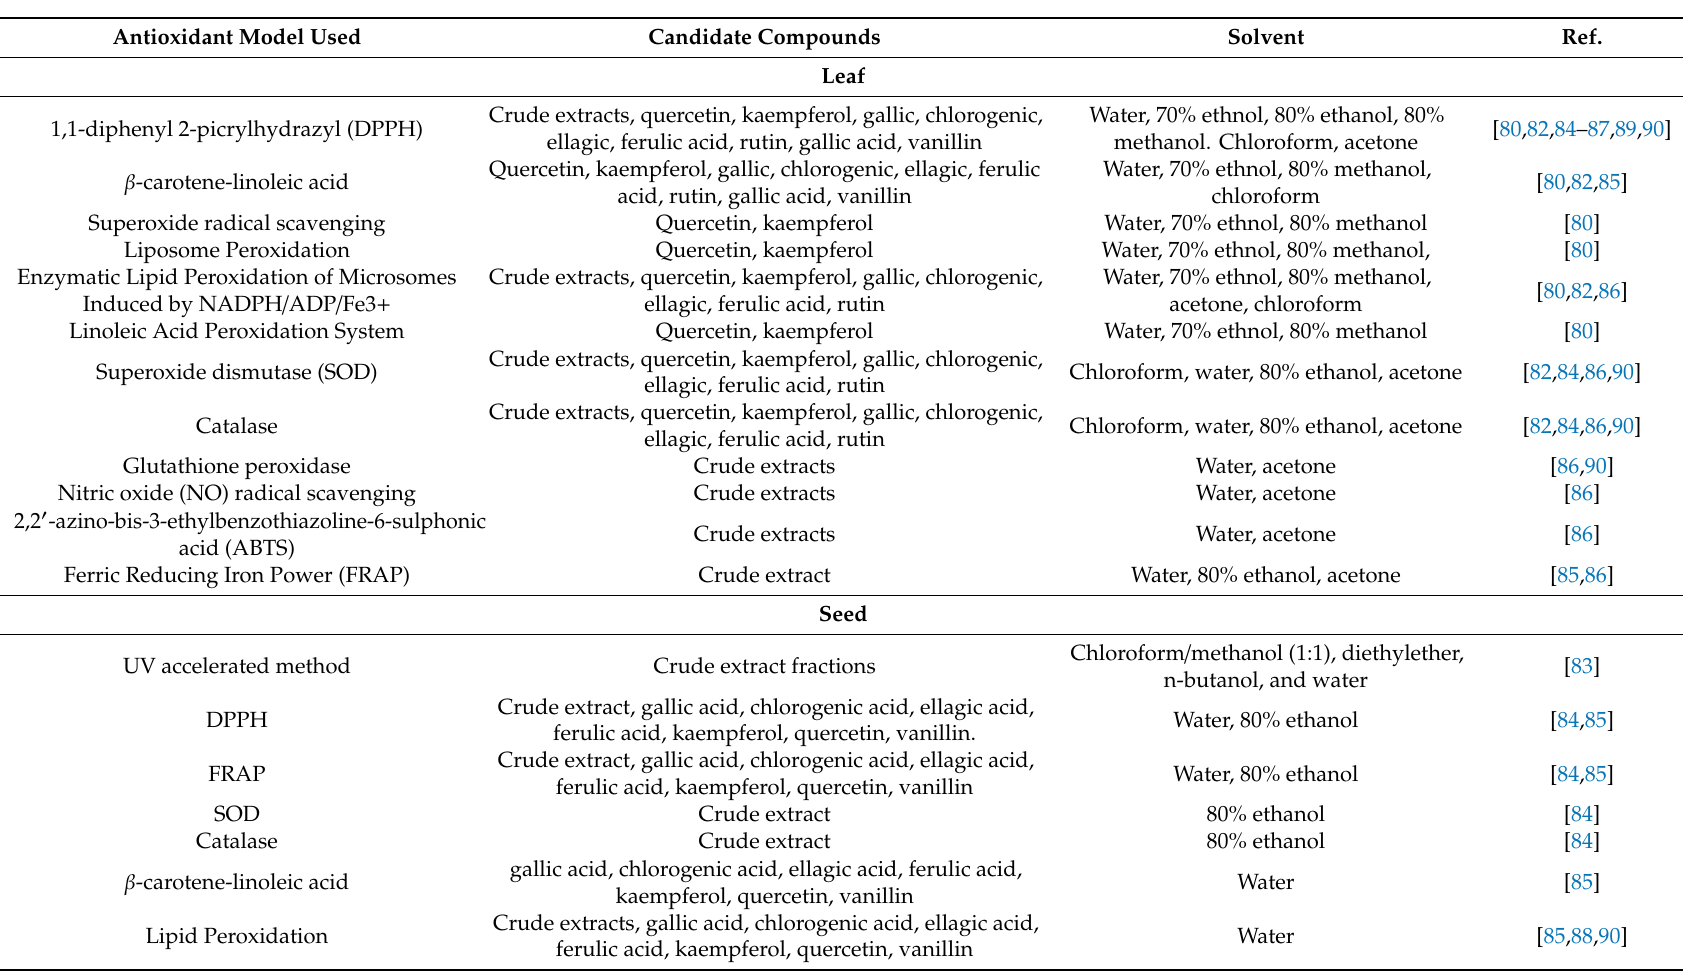
Table 2. Some reported antioxidant properties of di ff erent plant parts of M.